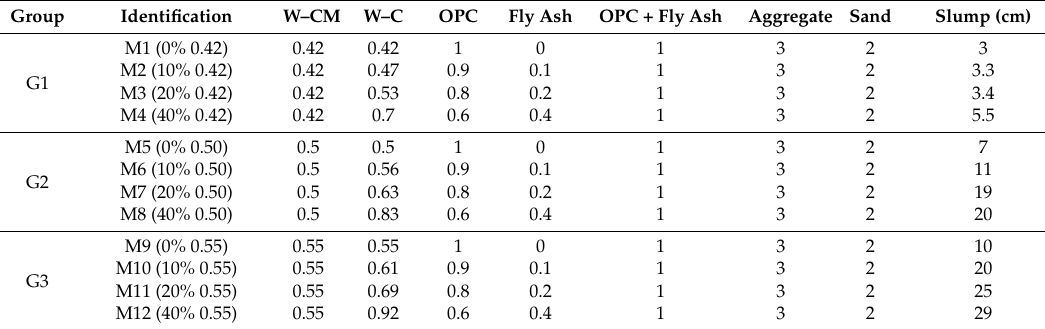
Table 2. Mix proportions for the concretes used in the preparation of the